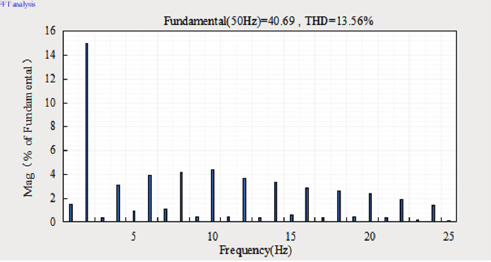
Figure 12. Current FFT analysis after PI control compensation.